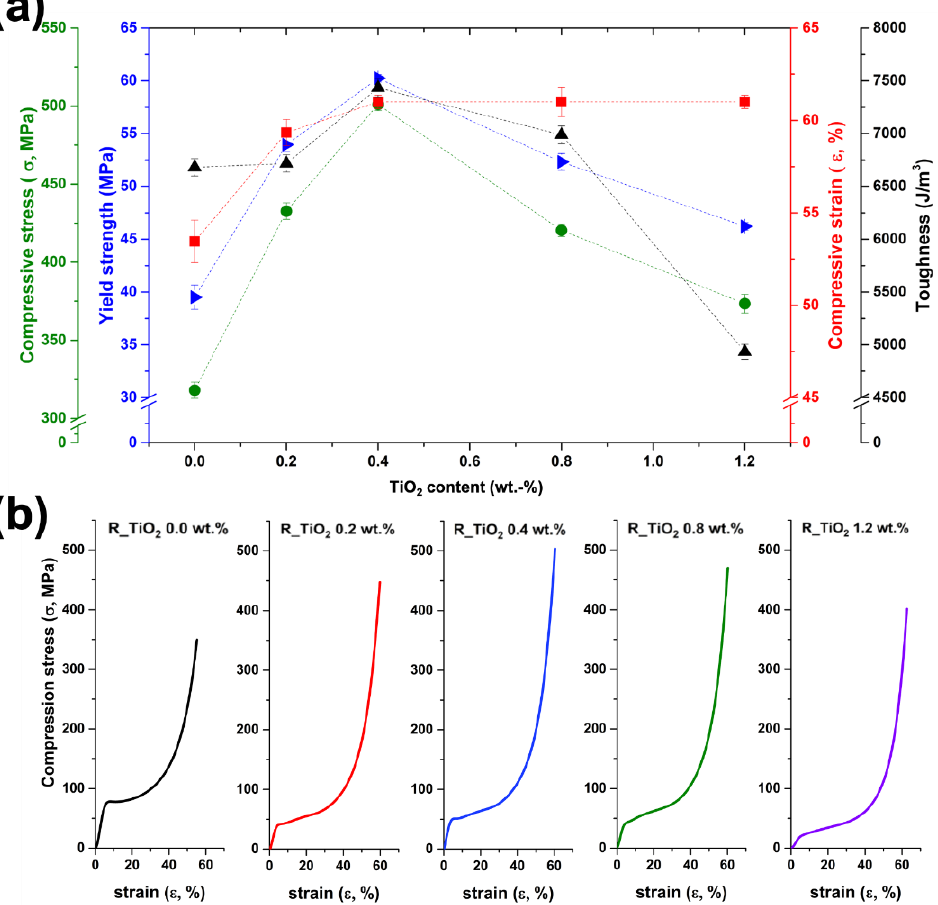
Figure 3. Mechanical properties (compression) of the 3D-printed polymer nanocomposites: ( a ) Com- pressi ve stress (σ), compressive strain (ε), yield strength, and toughness data as a function of the TiO 2 NP content. ( b ) Compressive stress –strain curves (σ–ε) for all